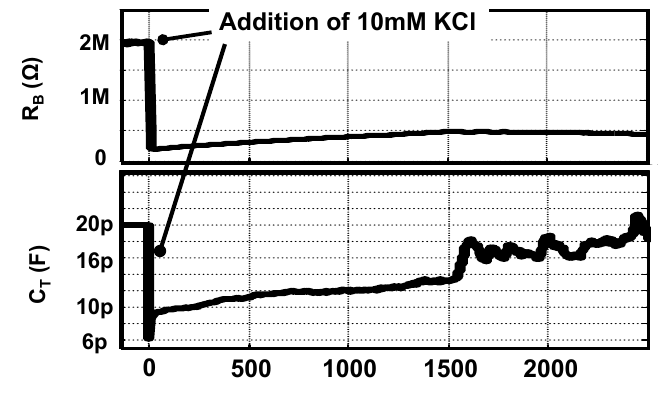
Figure 13. Real time control